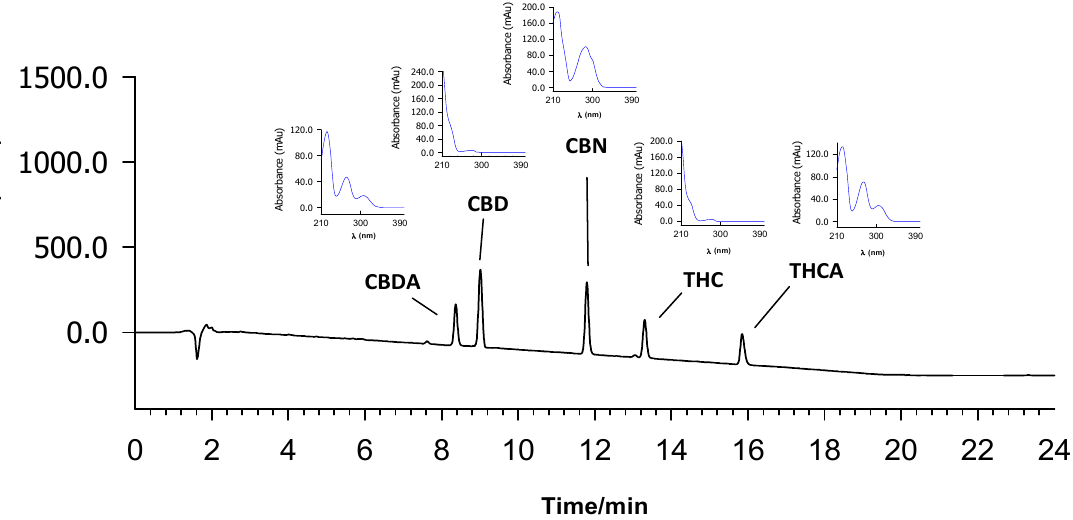
Figure 1. HPLC-UV chromatographic profile of a cannabinoid standard mixture at 1 mg/mL. The observed retention times were 8.2 min for CBDA, 8.9 min for CBD, 11.7 min for CBN, 13.1 min for THC, and 15.7 for THCA. The UV detector was set at 220 nm for THCA, CBDA, and CBN detection and at 210 nm for THC and CBD detection.